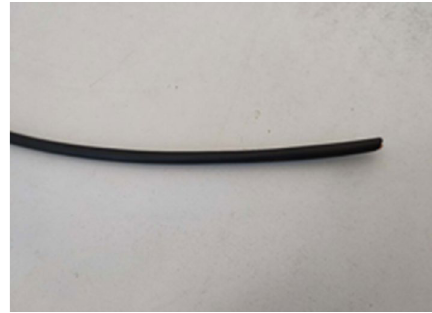
Figure 12. Multi-core copper cable.